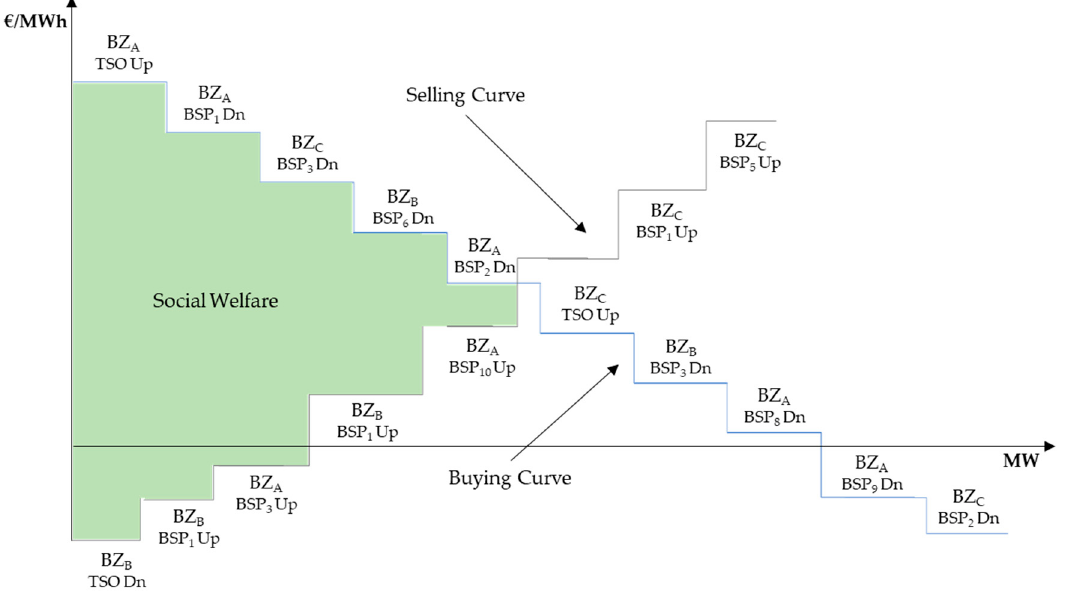
Figure 3. Example of a Common Merit Order List.